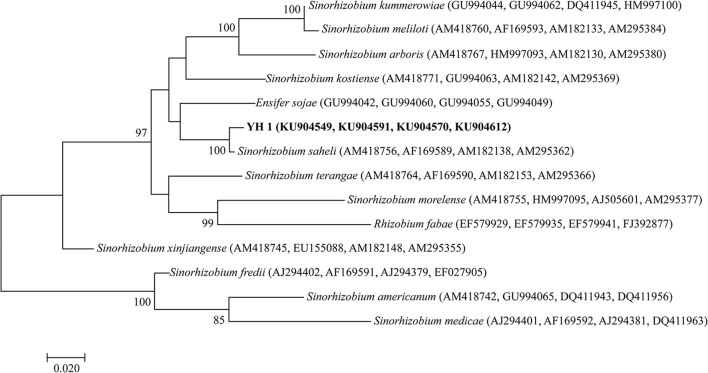
Concatenated tree of L. leucocephala-isolated strain YH1 combining atpD-glnII-recA-rpoB (1,631 bp), generated using maximum likelihood method (Kimura 2-parameter model) with 1,000 repetitions of bootstrap value. Accession numbers retrieved from GenBank are shown in parentheses. The scale bar denotes 2% nucleotide substitutions per site. Values lower than 50 are not shown at the nodes.